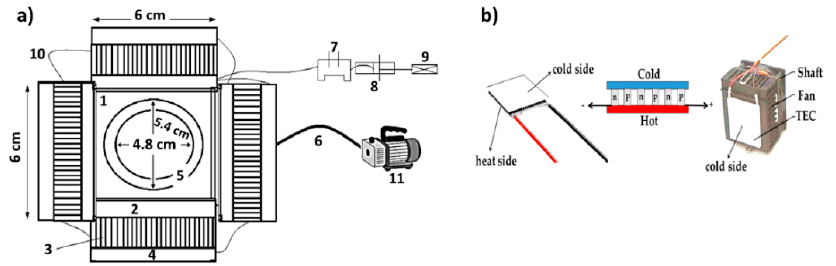
Figure 2. ( a ) Schematic of the freeze-drying system and ( b ) the TEC: interior view of TEC and the connection of the heat side of TEC to the fan via a shaft.